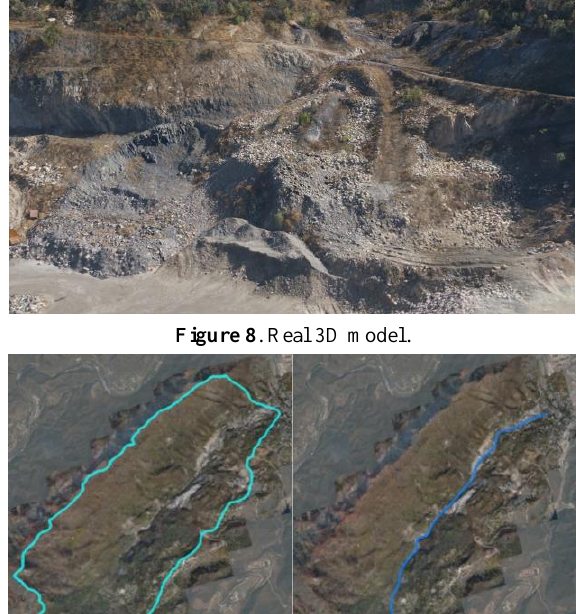
Figure 6 . Earthwork analysis.